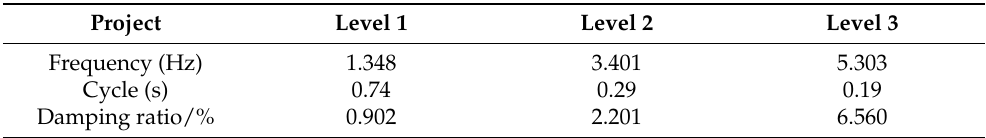
Table 7. The Small Wild Goose Pagoda dynamic characteristic